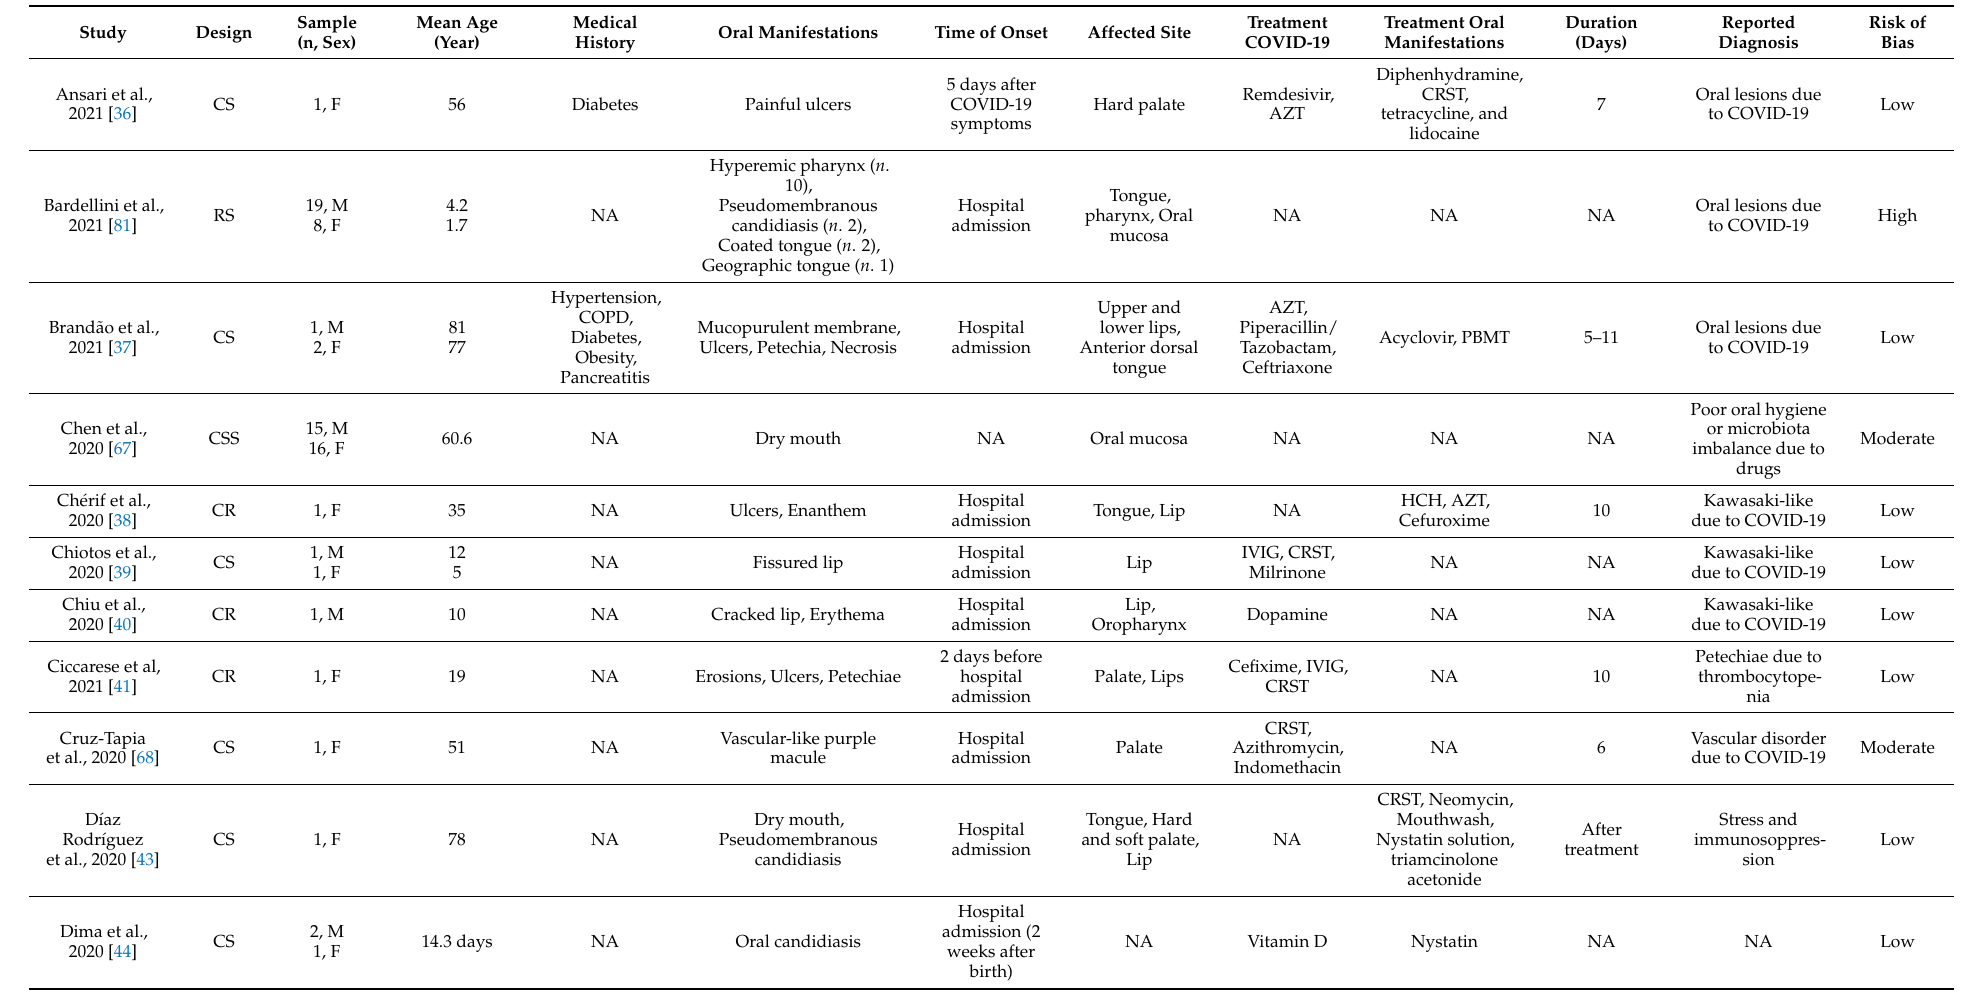
Table 1. Descriptive characteristics of included studies regarding oral lesions that appeared before hospitalization in patients affected by COVID-19. F: female; M: male; CS: cases series; RS: retrospective study; CSS: cross-sectional study; CR: case report; OS: observational study; NA: not available; COPD: chronic obstructive pulmonary disease; AZT: azithromycin; CRST: corticosteroids; IVIG: Intravenous immunoglobulin; PDT: Photodynamic therapy; PBMT: Photobiomodulation therapy; HCH: hydroxychloroquine; ASA: acetylsalicylic